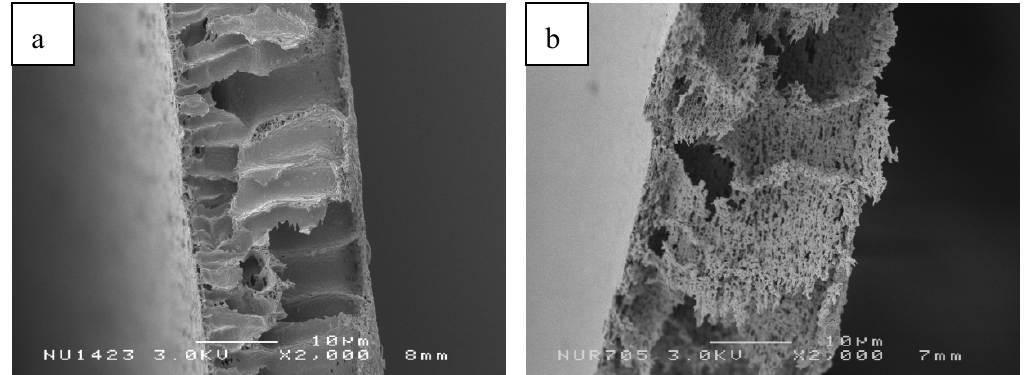
Figure 4. SEM photograph of the cross section of ( a ) PES10/D6 and ( b )